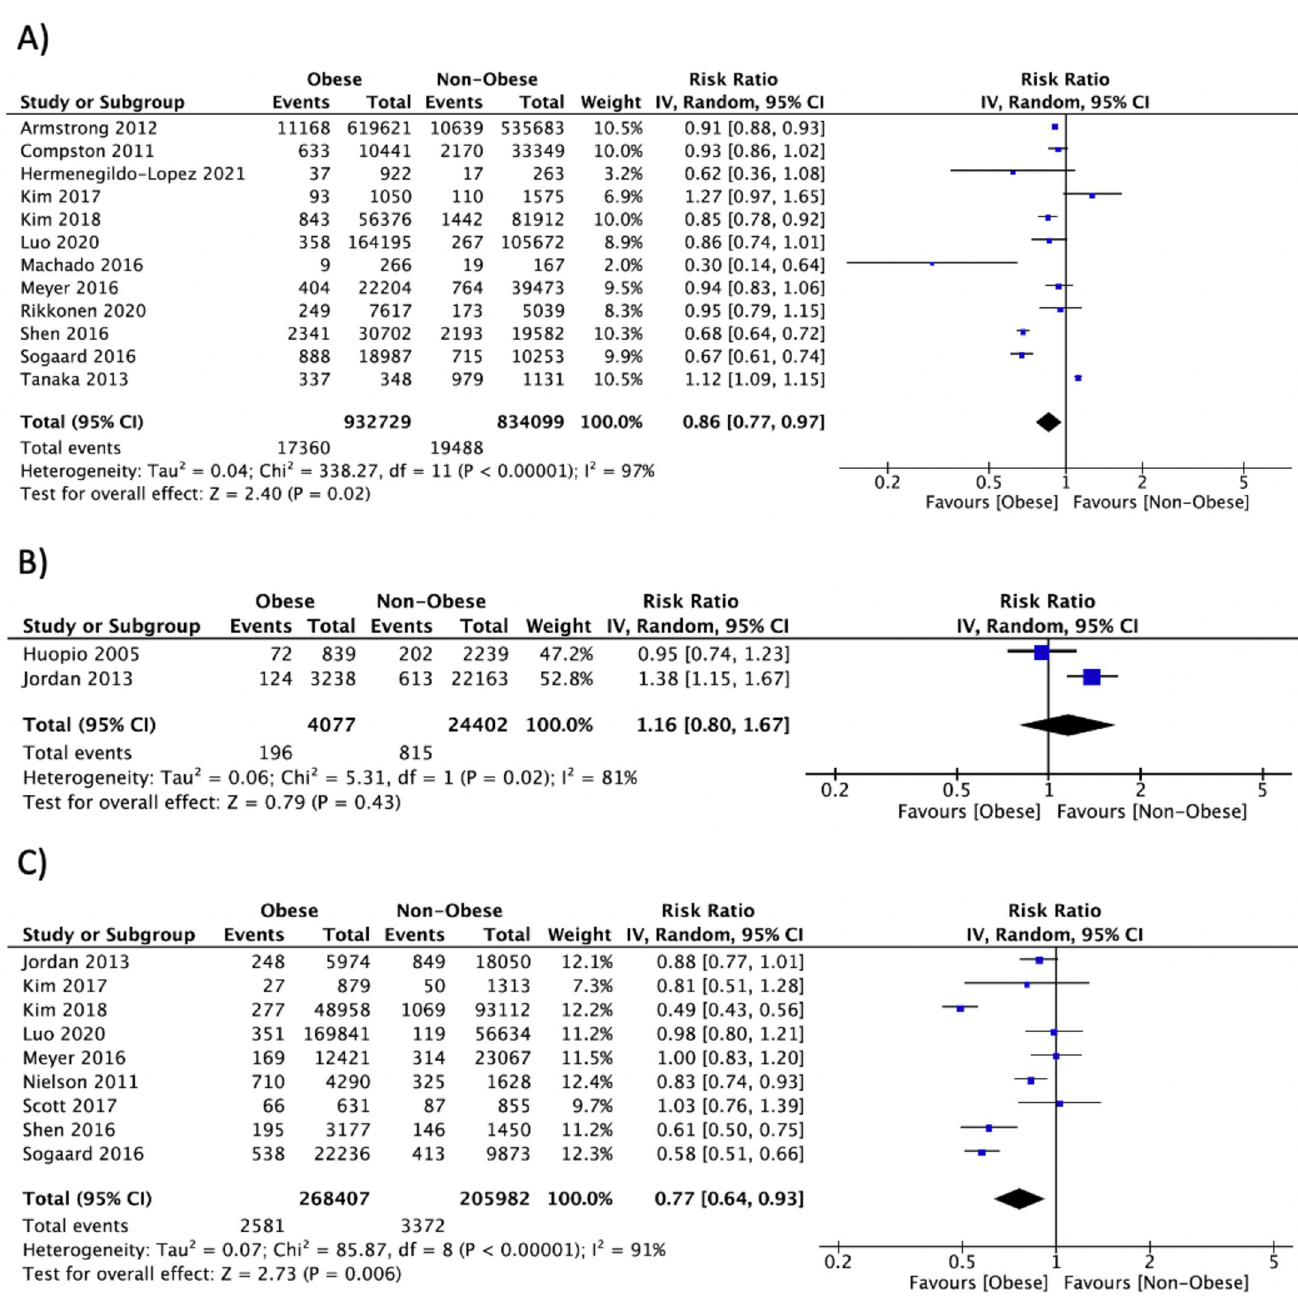
PLOS ONE | https://doi.org/10.1371/journal.pone.0252487 June 8,